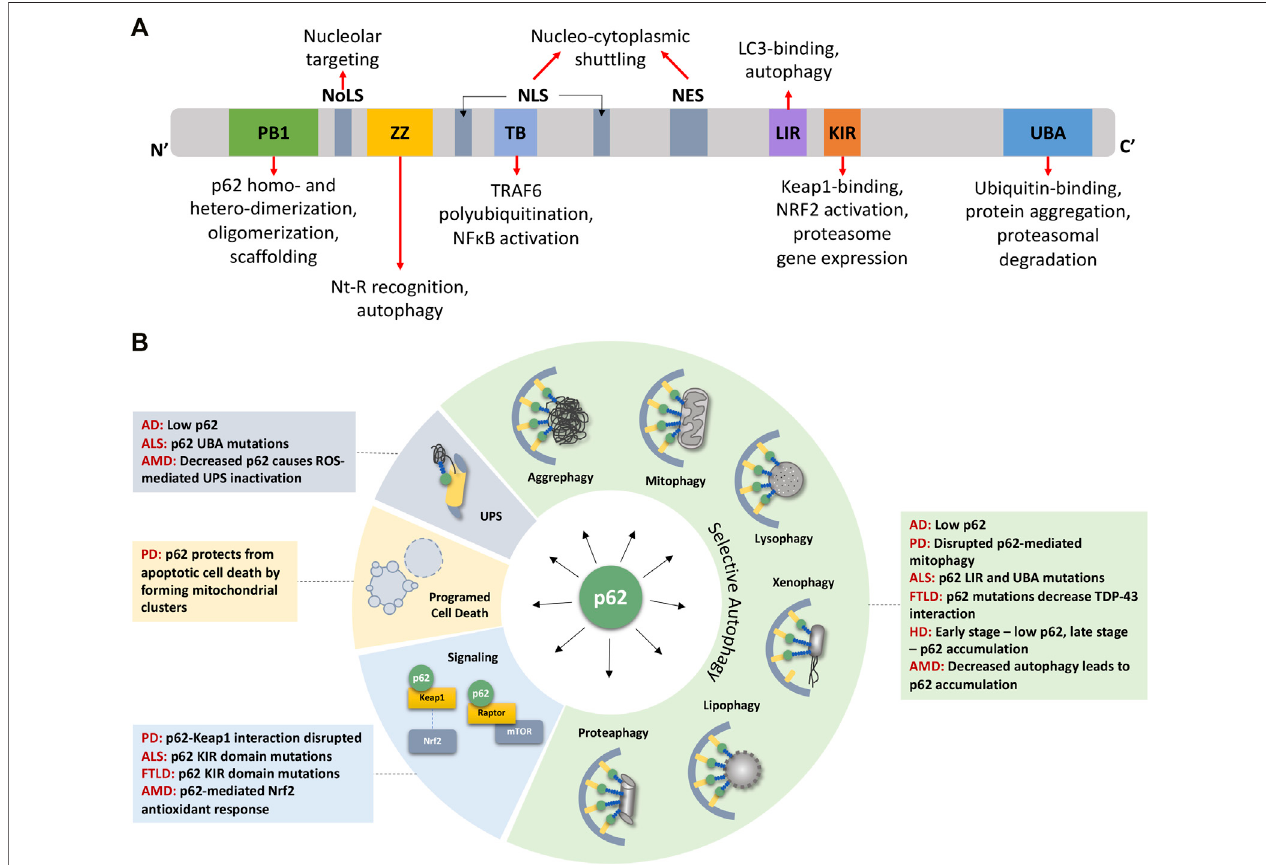
FIGURE 1 | p62 domains, its multifaceted nature, and its impact on detriments associated with age-related degenerative diseases. (A) p62 protein consists of severalwell-characterized domainsthatinteract withvariousproteins leadingtop62 ’ sinvolvement indiversefunctions(seetextfordetails). (B) p62plays rolesinvarious forms of selective autophagy, the UPS, programmed cell death, and signaling pathways. These functions are disrupted owing to mutations or aberrant expression/ accumulationofp62inseveralage-relateddegenerativediseasesdiscussedinthisreview.ADAlzheimer ’ sDisease,ALSAmyotrophicLateralSclerosis,AMDAge- related Macular Degeneration, FTLD Frontotemporal Lobar Degeneration, HD Huntington ’ s Disease, NES Nuclear Export Sequence, NLS Nuclear Localization Sequence, NoLS Nucleolar Localization Sequence, PD Parkinson ’ s Disease.